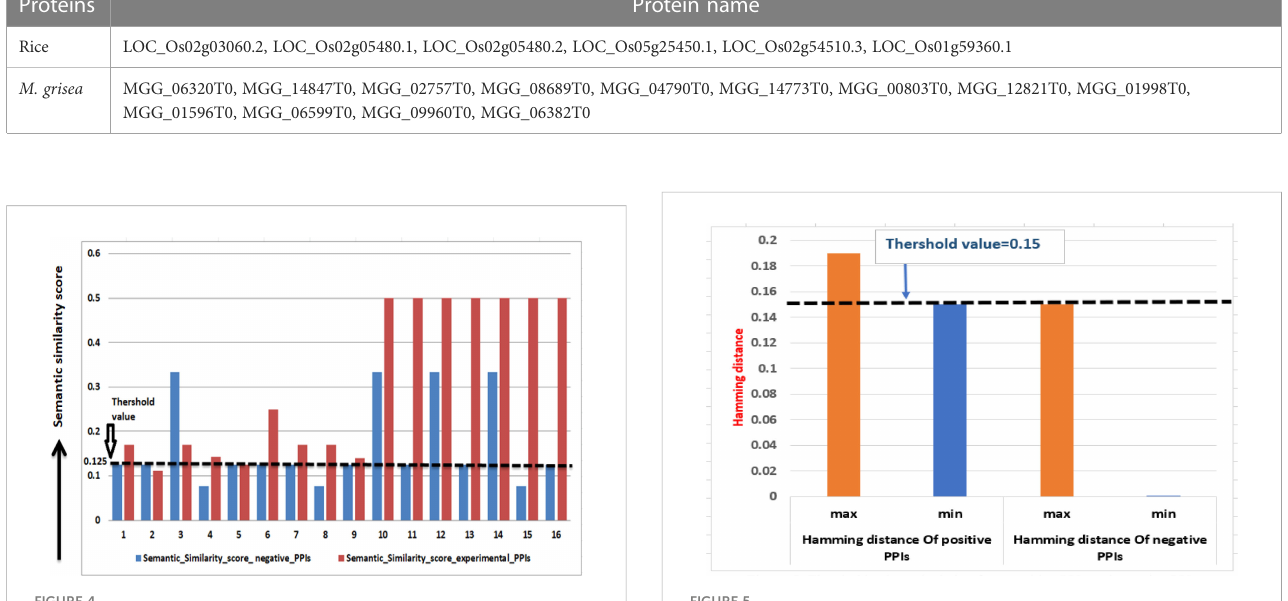
FIGURE 4 Threshold value calculation from experimentally veri fi ed PPIs.